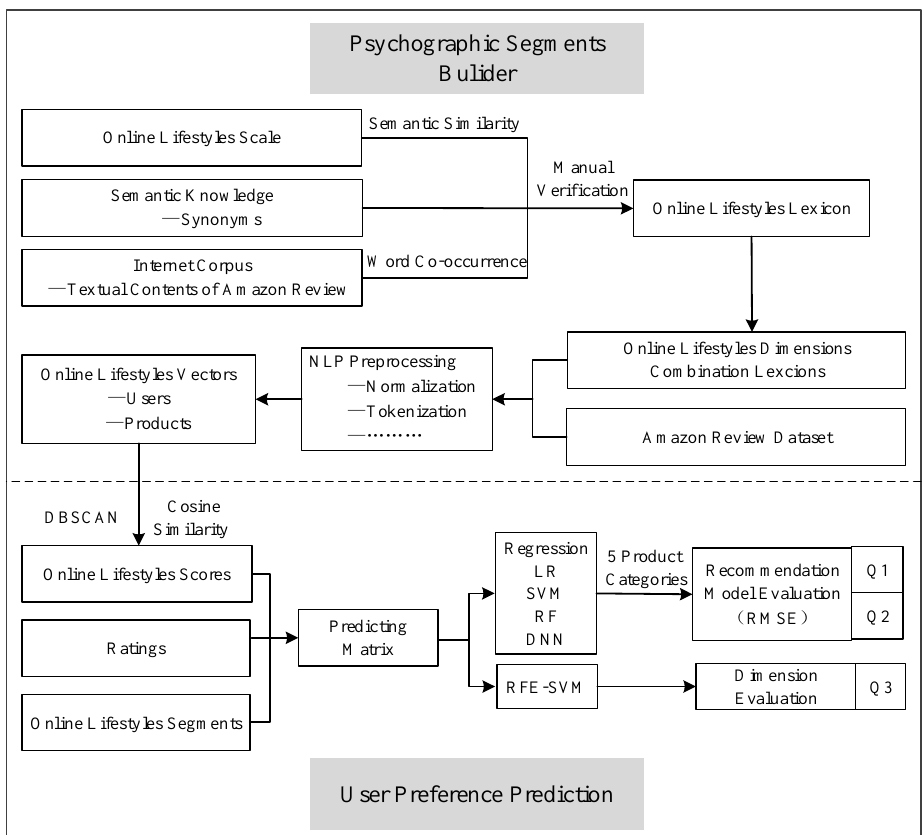
Figure 3. Experiment process.